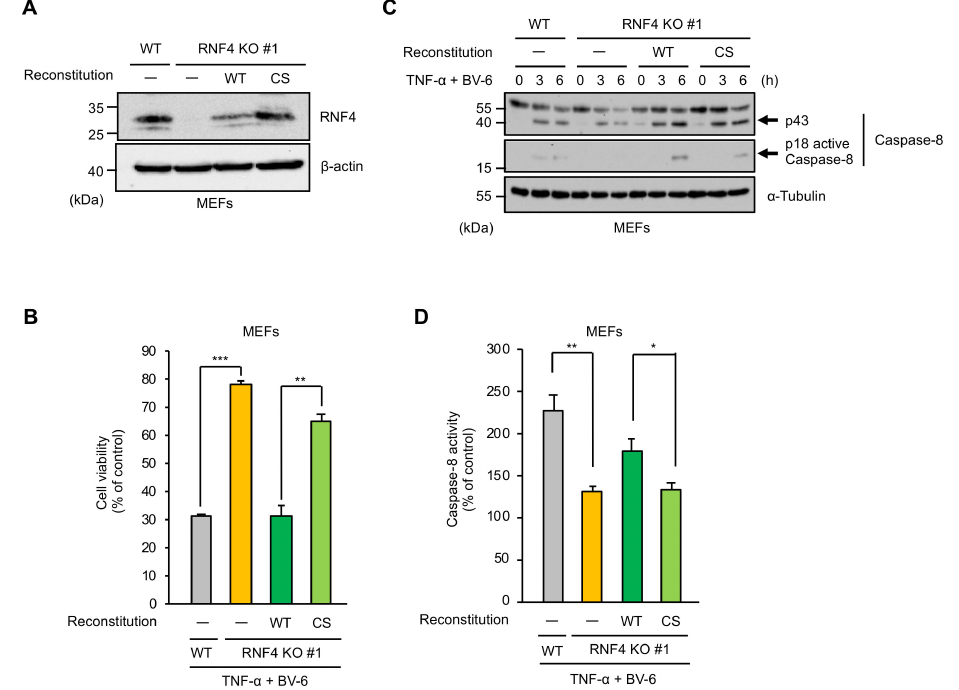
Figure 2. The E3 ubiquitin ligase activity of RNF4 is required for TNF- α -induced apoptosis. ( A ) Immunoblot analysis of RNF4 in MEFs. MEFs were subjected to immunoblotting with the indicated antibodies. β -actin was used as a